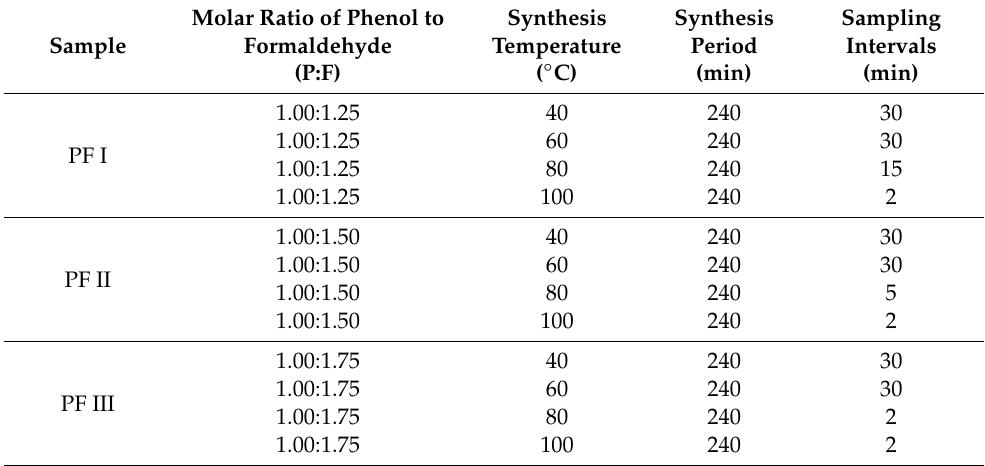
Table 1. Set conditions for the synthesis of phenol formaldehyde (PF)